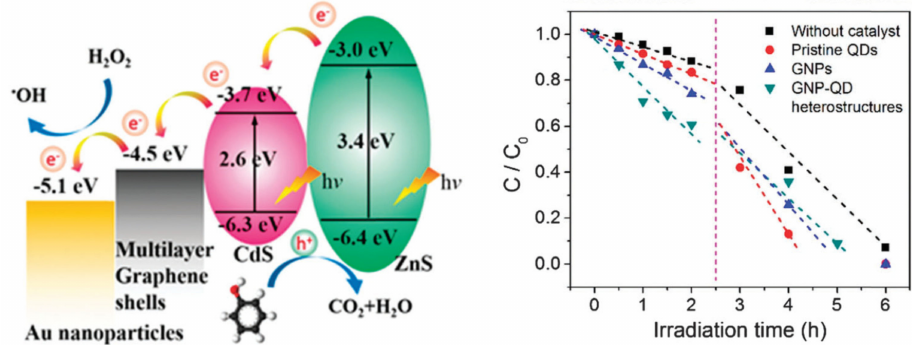
Figure 10. The charge transfer mechanism ( left ) of the quaternary composite formed from ZnS/CdS/graphene shells and Au; the degradation of phenol ( right ) in the presence of the quaternary composite (Reproduced with permission from Reference [150] published by the Royal Society of